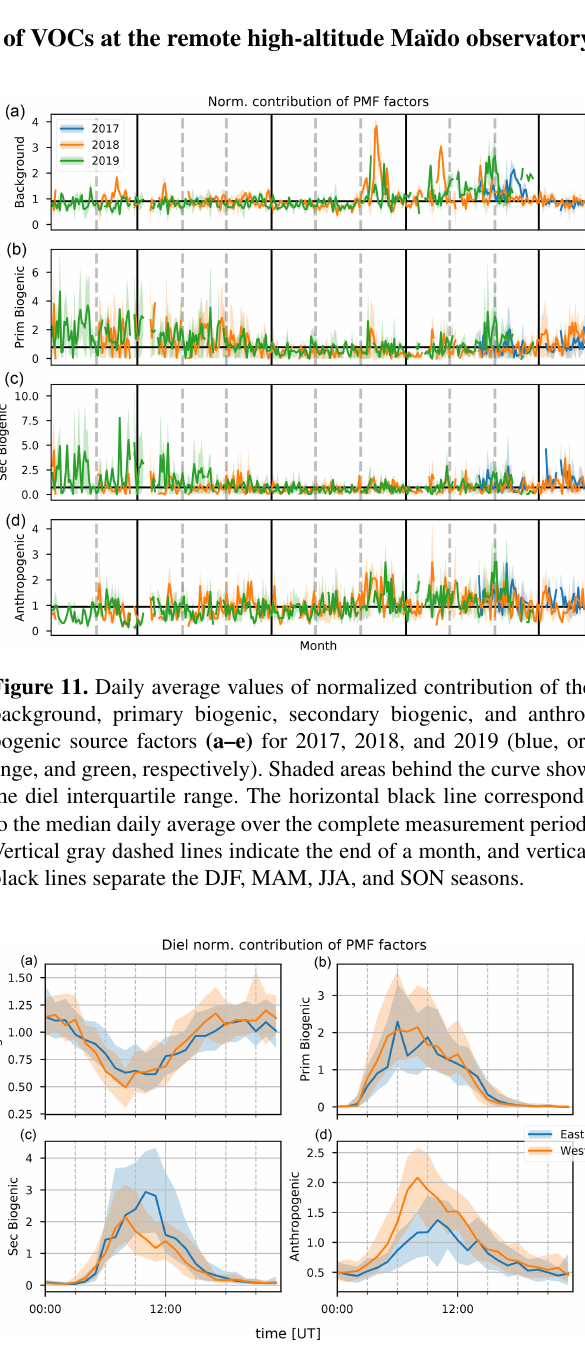
Figure 12. The median diel profile of background, primary bio- genic, secondary biogenic, and anthropogenic factor (a–d) normal- ized contributions separated along the wind directions recorded at the observatory (blue for air masses coming from the east and or- ange from the west); hourly interquartile ranges are visualized by the shaded area behind each